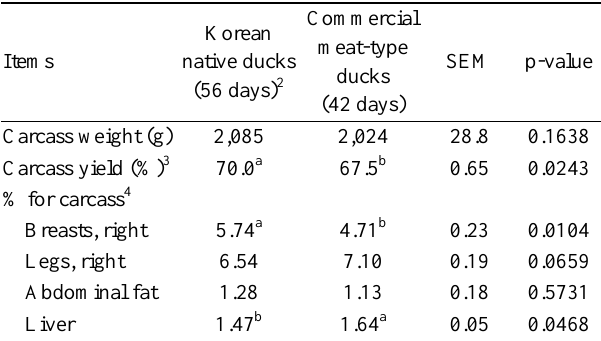
Table 3. Carcass characteristics of the Korean native ducks